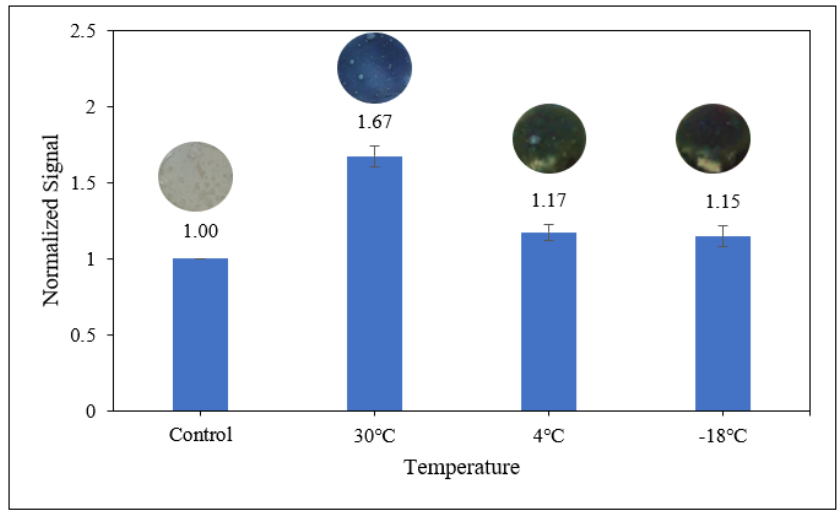
Figure 12. The colourimetric response of starch/PANI 0.4% to 1000 ppm ammonia solution at different temperatures (30 °C, 4 °C and − 18 °C).